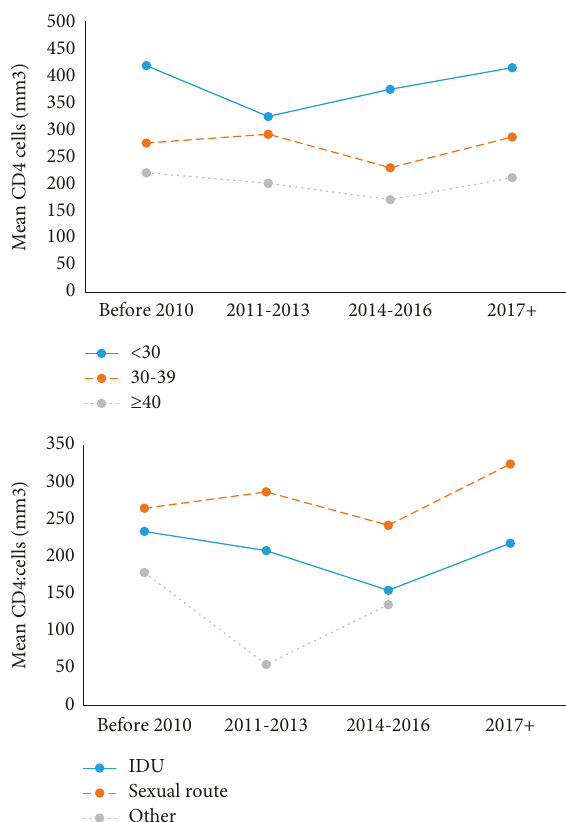
Figure 2: Changes of mean baseline CD4 cell counts from 1997 and 2021 stratified by age groups and transmission groups. Table 2: Risk factors associated with baseline CD4 (linear regression model), Iran, 1997–2021.